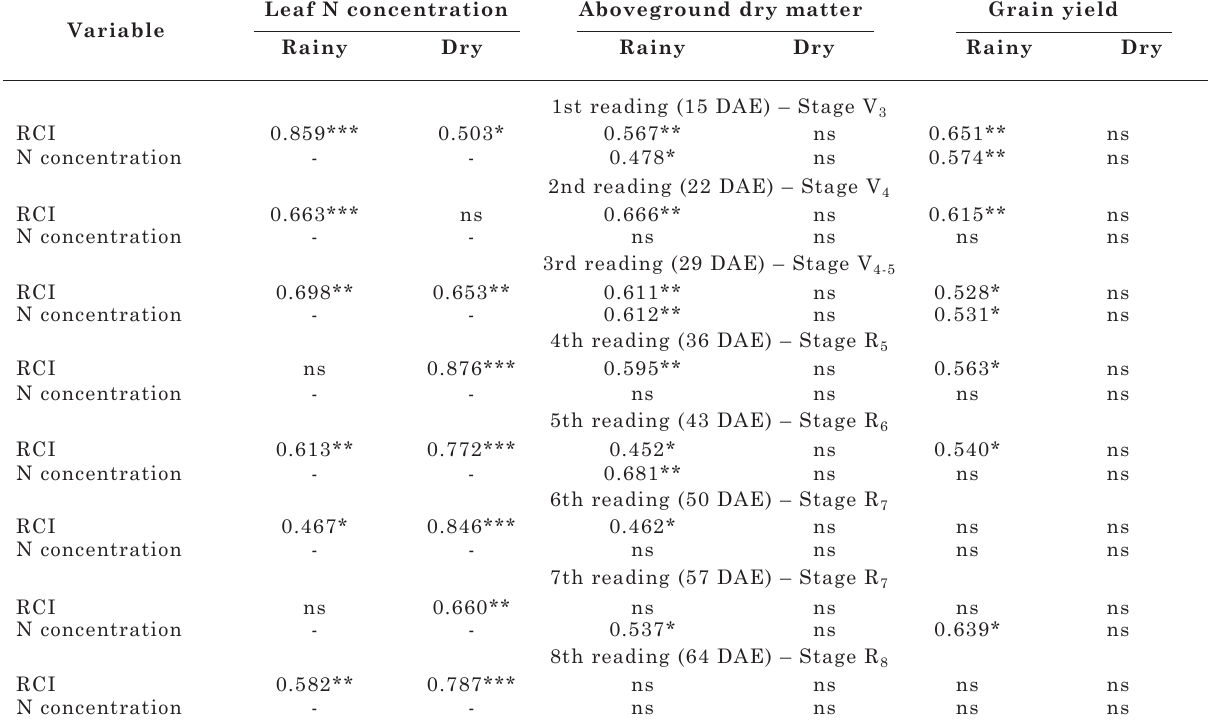
Table 2. Simple linear correlation coefficients for relative chlorophyll index (rci), leaf N concentration at each evaluation, aboveground dry matter determined at stage r 6 and grain yield of common bean cv. Perola, in the rainy and dry growing seasons